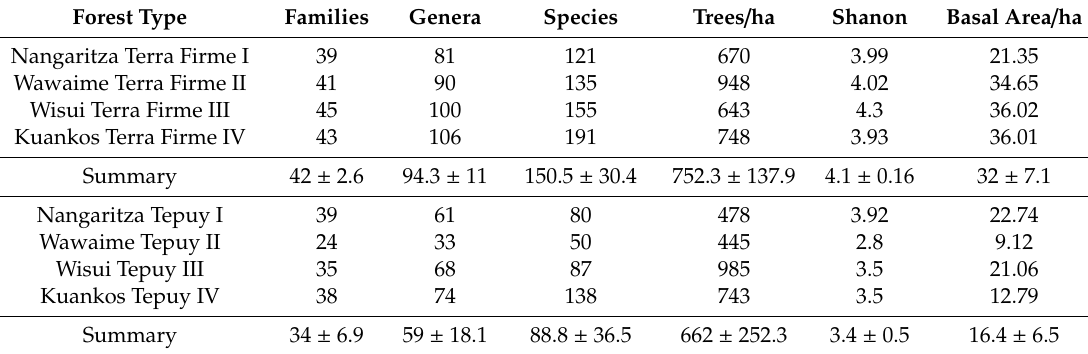
Table 3. Descriptive values of the attributes of the forests in each